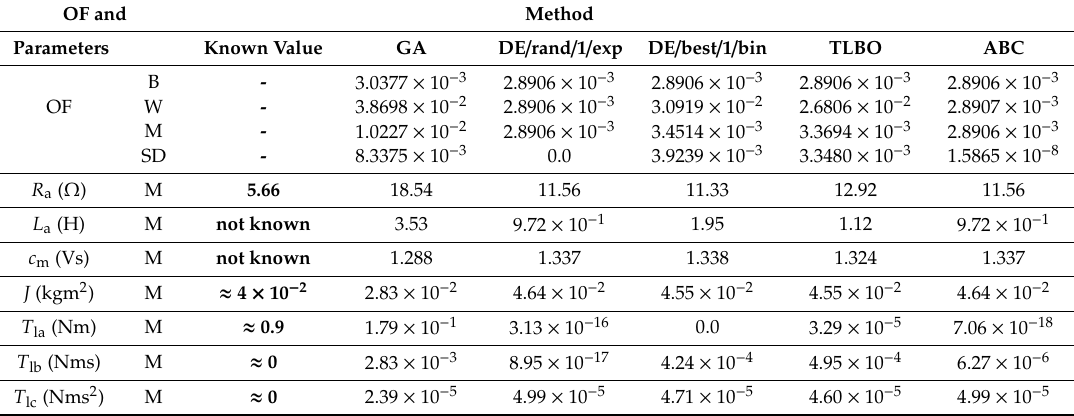
Table 9. OF and Mean value of the calculated parameters for 50 independent runs using EM for MD1. OF and